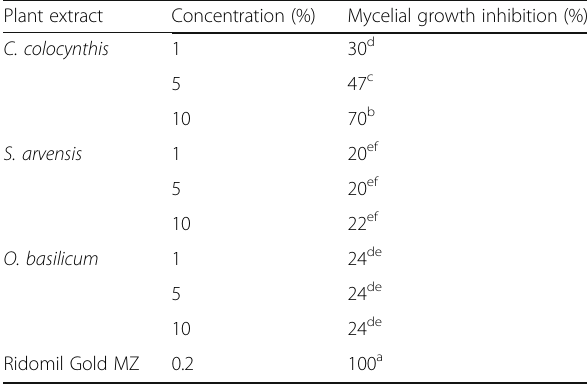
Table 2 Effect of some plant extracts on the growth of Botrytis allii , the causal of Botrytis onion umbel blight (BOUB) diseases, in vitro Plant extract